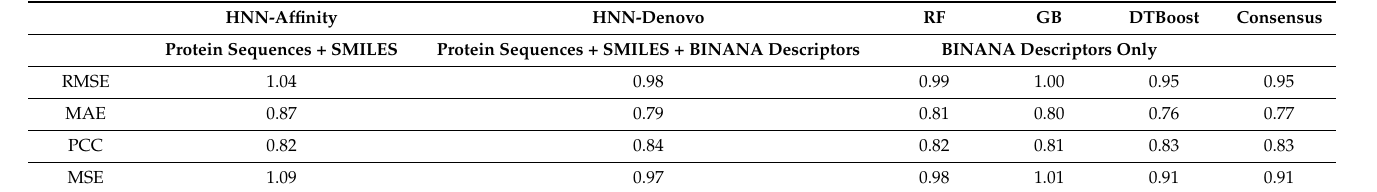
Table 1. The comparative results of the HNN-denovo, and